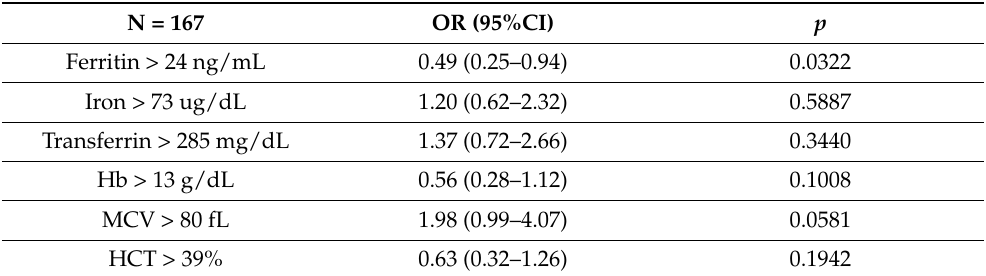
Table 2. Results of multiple logistic regression for hematologic variables and presence of ASD, adjusted for age and sex.